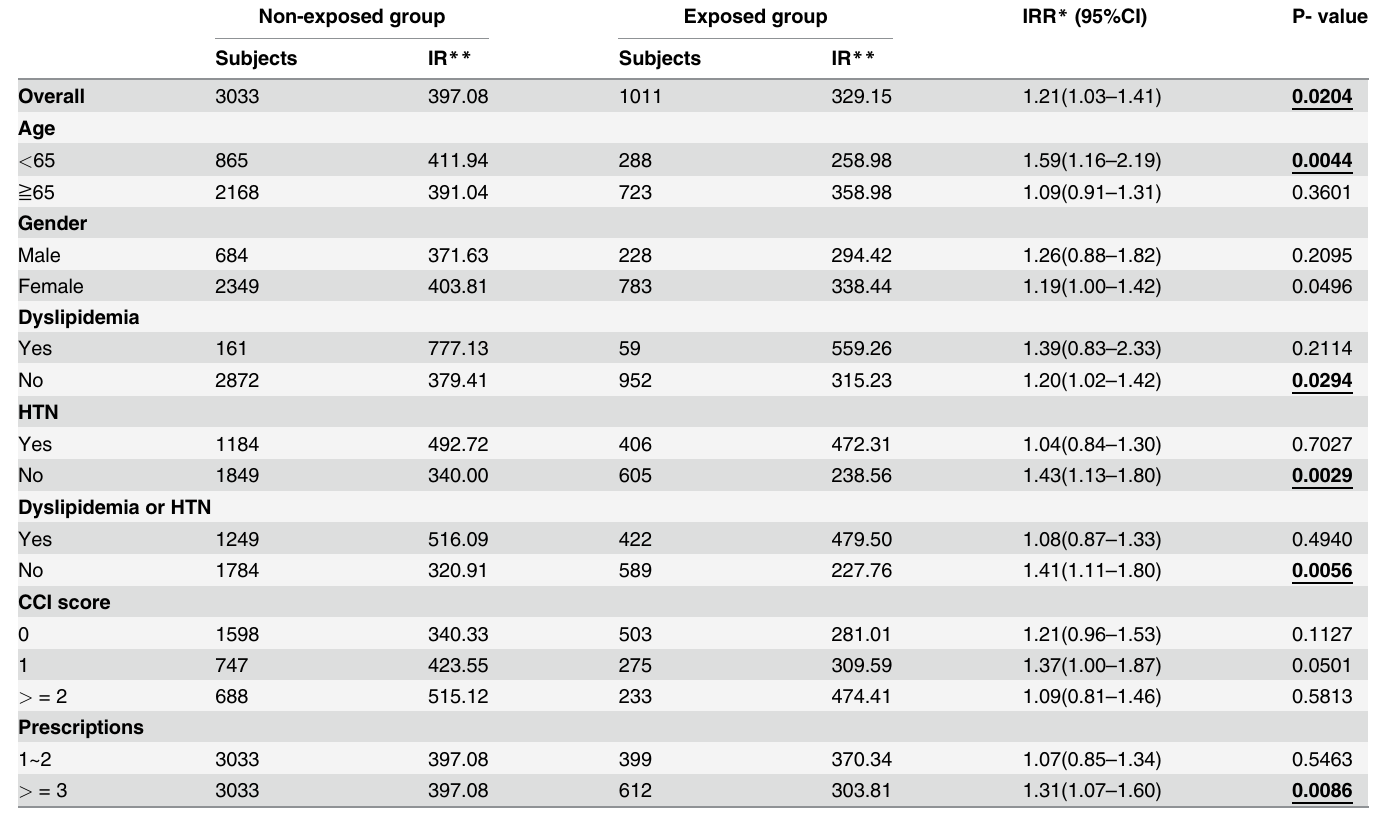
Table 2. Comparison for Incidence of type 2 DM between exposed and non-exposed